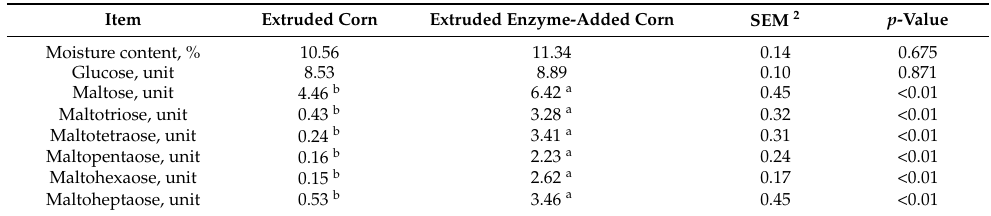
Table 3. Effects of different enzymes (adding 4 kg/t α -amylase or not) being added to extruded corn on the moisture content and maltooligosaccharides contents of extruded corn 1